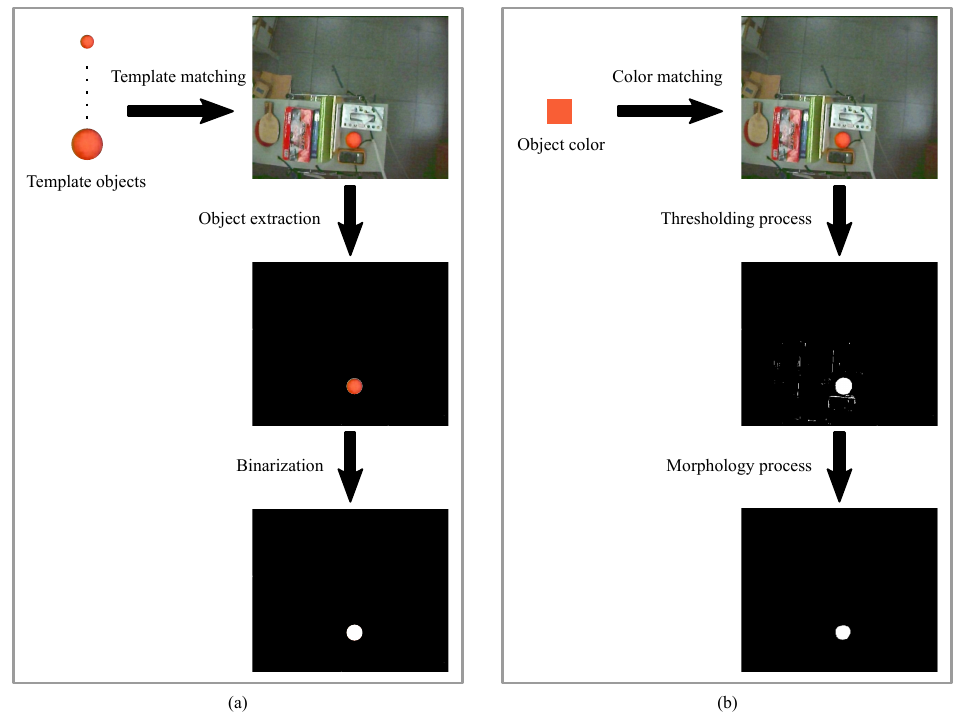
Figure 3. Simulation results of the ( a ) template matching method and ( b ) color matching